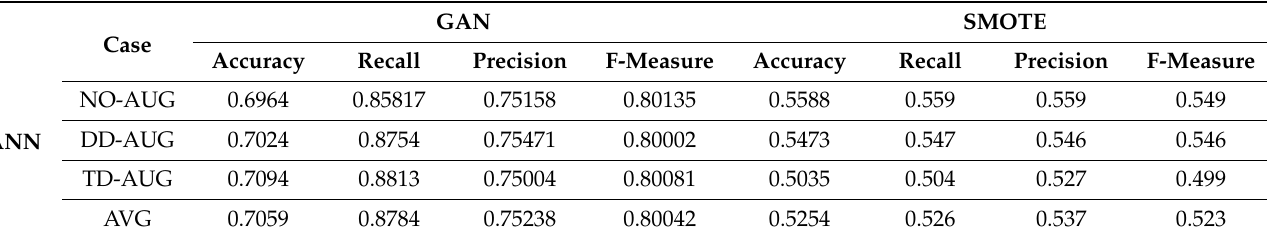
Table 6. Evaluation of ANN Classifier for NO-AUG, DD-AUG and